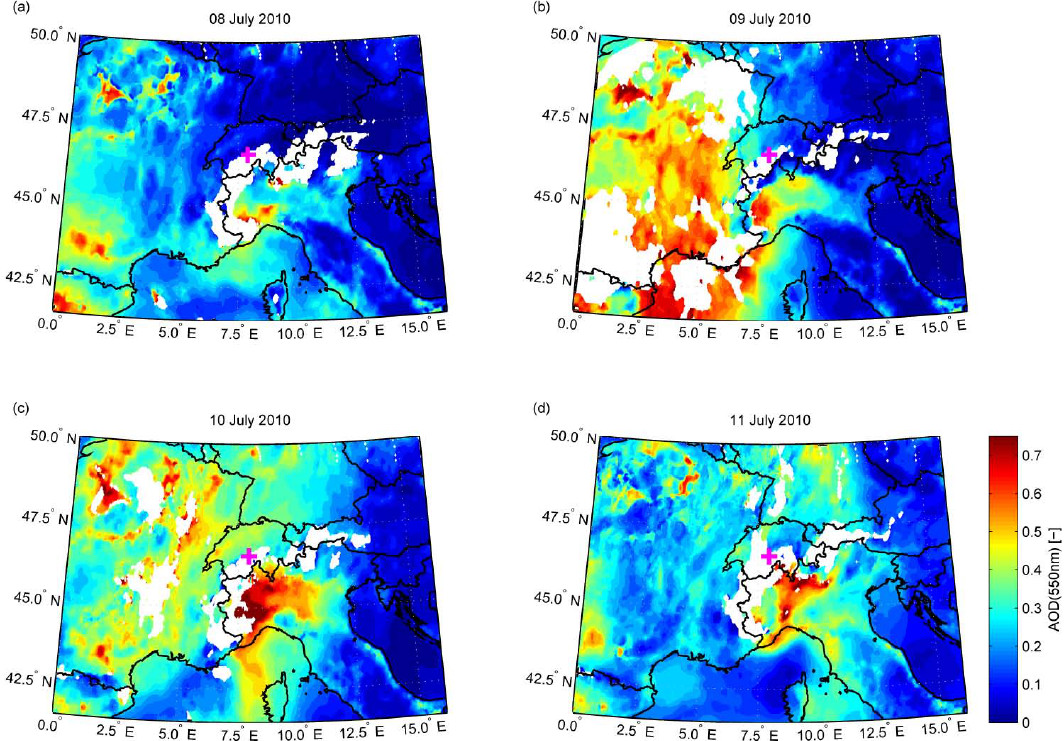
Fig. 8. Maps of daily averaged aerosol optical depth (AOD) retrieved from SEVIRI measurements for the time period of the Saharan dust event (8–11 July 2010) over Switzerland and neighboring countries. White areas are cloud and/or snow covered areas. The magenta cross denotes the location of the